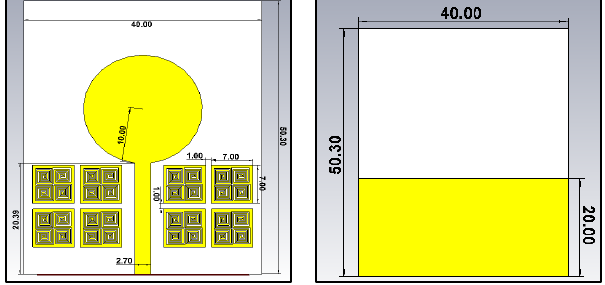
Figure 13. Designed UWB-CMSA with spiral EBG near the feed.